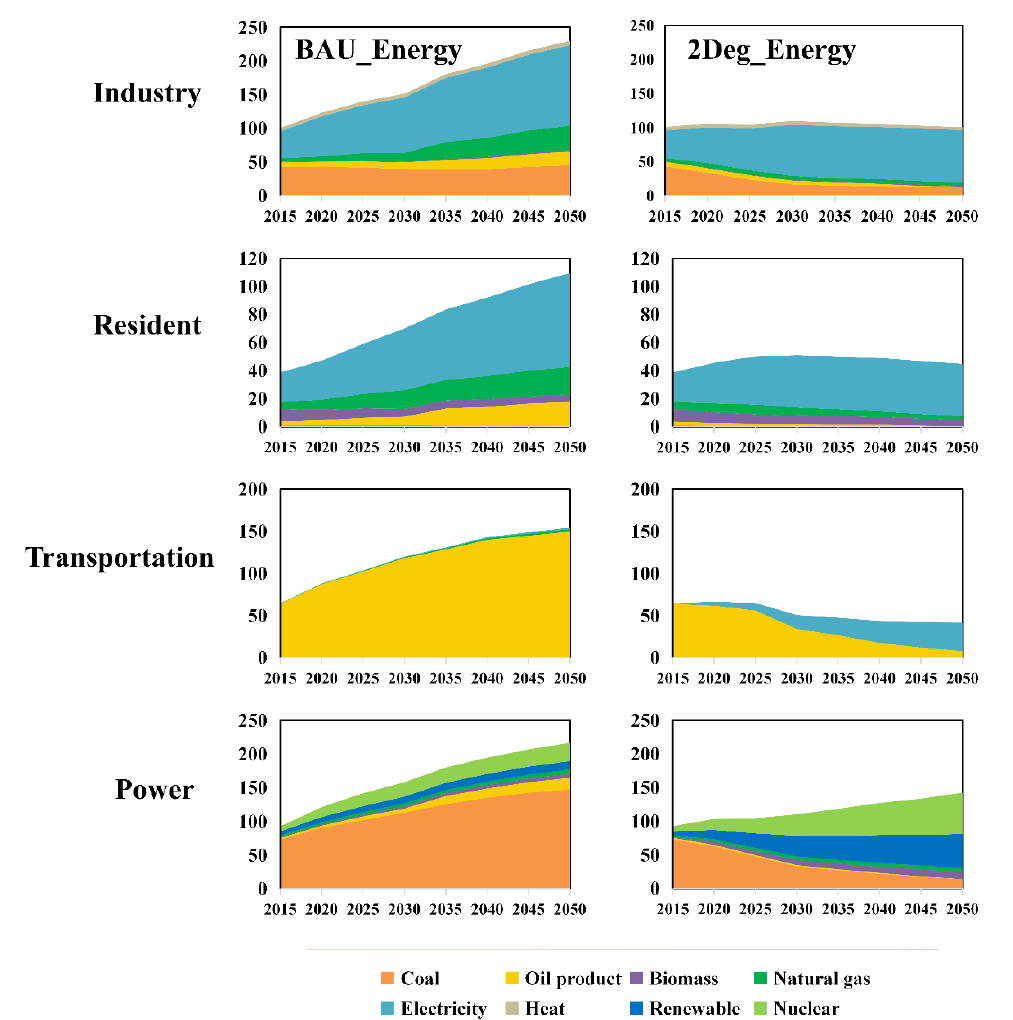
Figure 1. Comparison of energy structure change between the BAU_Energy and 2Deg_Energy scenarios in the future, units: Mtce.